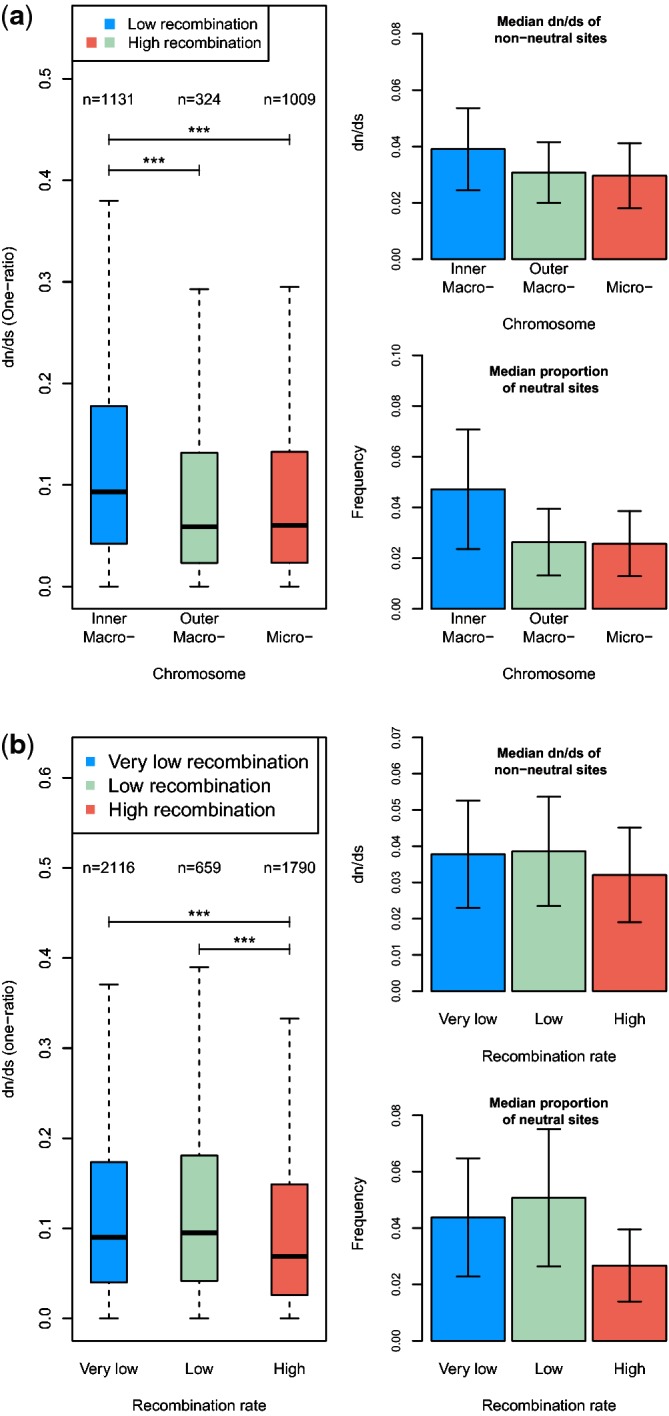
Box plots of
evolutionary rates for subsets of genes according to their
(a) chromosomal positions and
(b) recombination rate estimates. Whiskers are
drawn as implemented in the R-function box plot (see Materials and
Methods). The bar plots show the proportion of sites estimated to be
evolving under neutrality and the median dn/ds
value for sites inferred to be evolving under purifying selection by
the nearly neutral (model M1a) in PAML. Error bars indicate median
absolute deviations (MDA). ***P≤0.001
under the MWU.